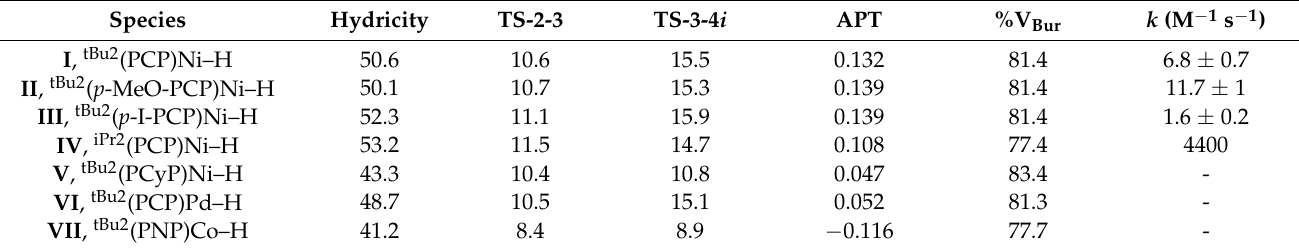
Table 1. Computed hydricity, %V Bur , and ∆ G ‡ for TM–H complexes I to VII .